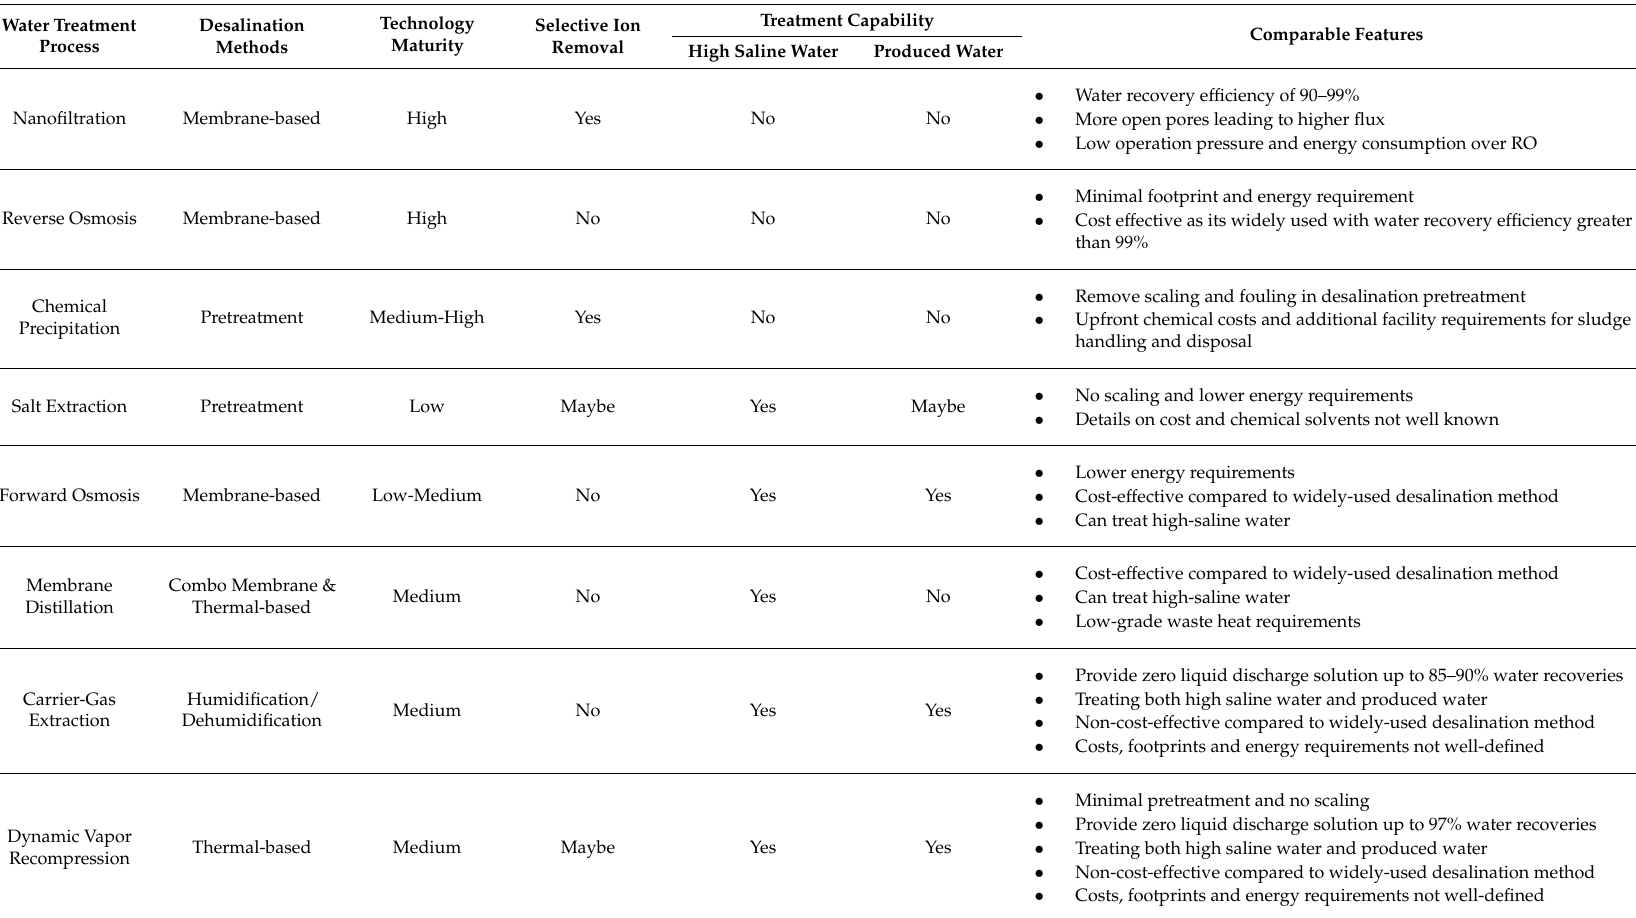
Table 3. Summary of technology selection criteria, key attributes and capabilities of both current and emerging water treatment technologies (adapted from Ayirala and Yousef